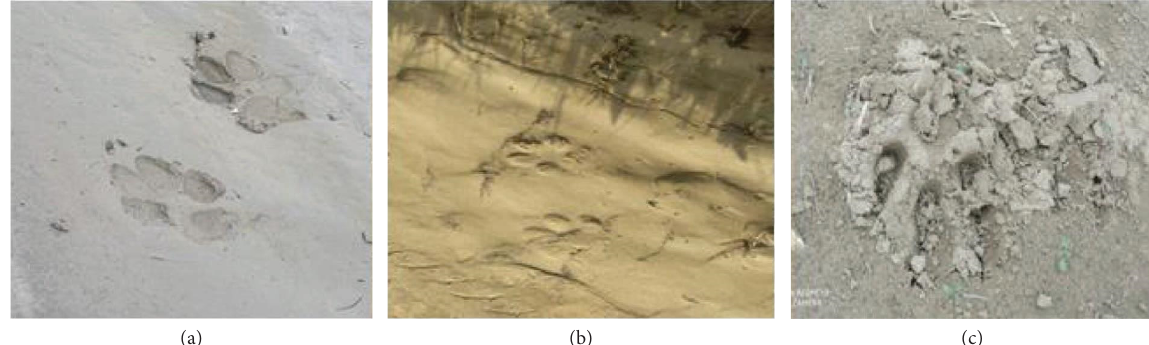
Figure 7: Wildlife penetration inside village boundaries of Parikshitgarh as visible through pugmarks of (a) jackal, (b) fshing cats, and (c) leopard.